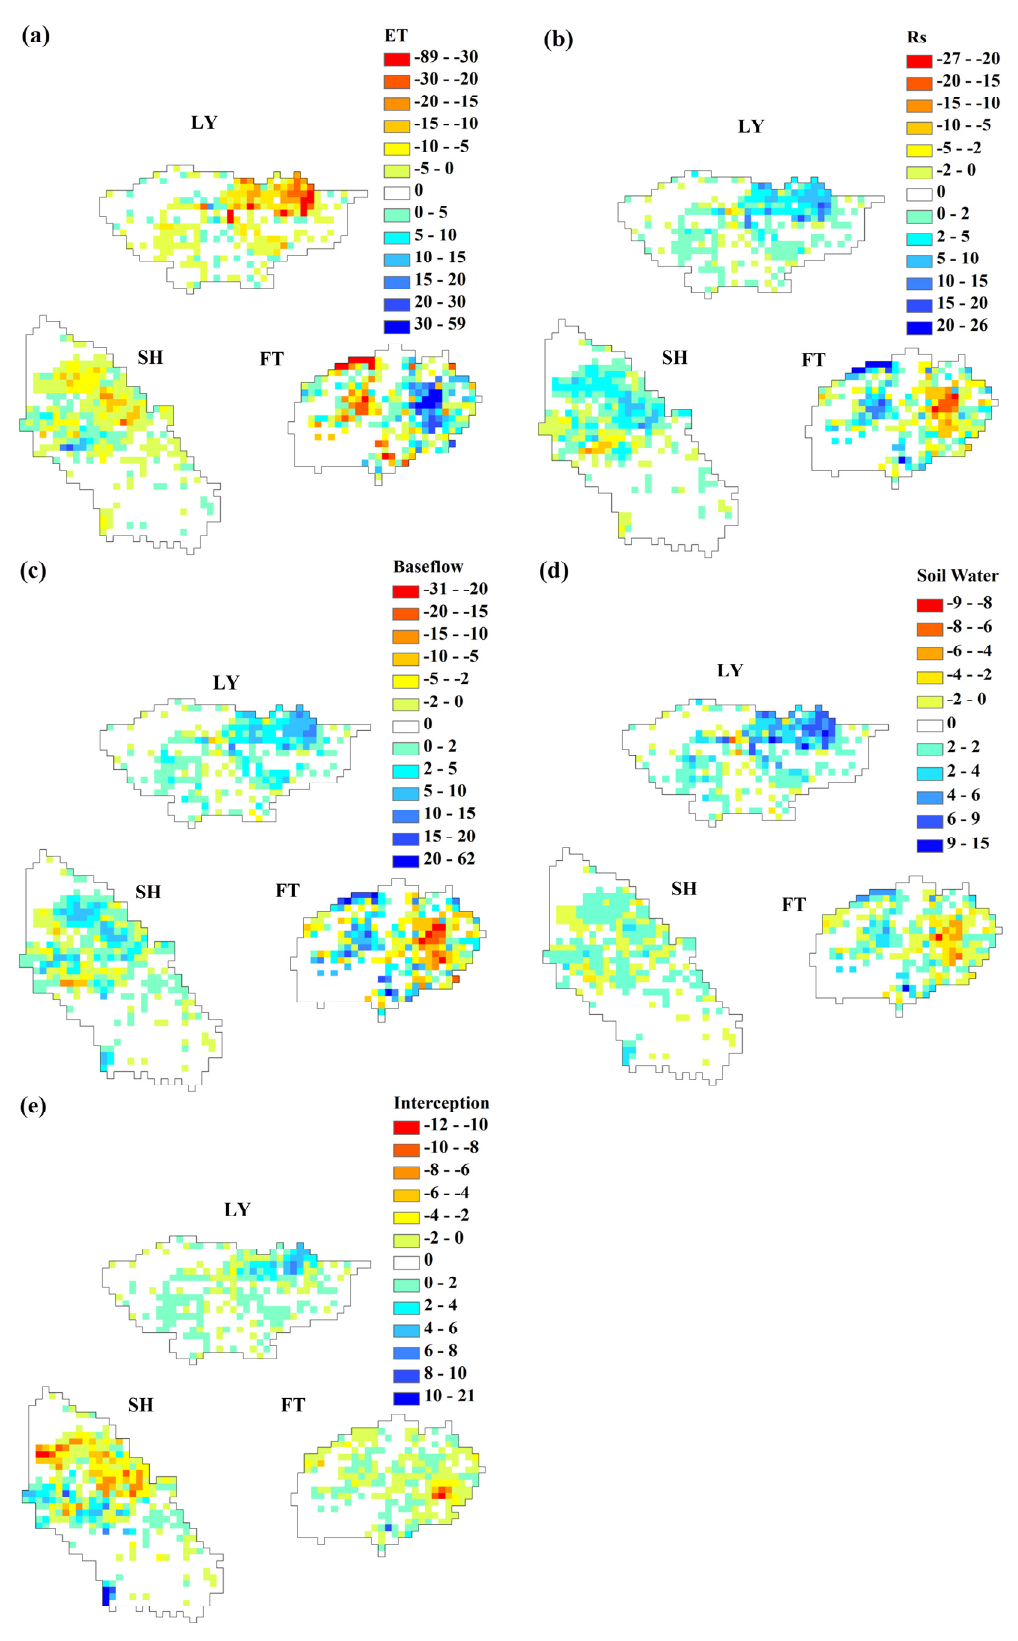
Figure 4. Differences in the hydrological elements in Scenario S1-S0: ( a ) change in evapotranspiration; ( b ) change in surface water generation; ( c ) change in baseflow; ( d ) change in soil water; and ( e ) change in canopy